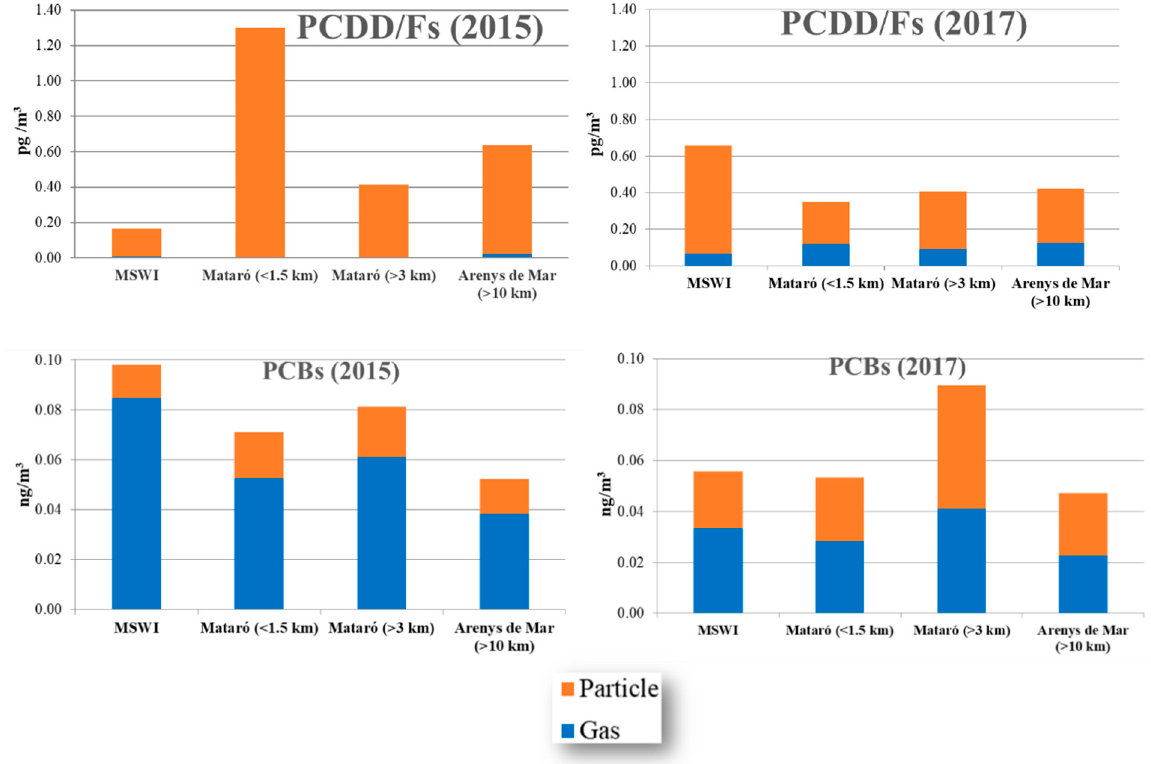
Figure 5. Gas / phase partitioning of PCDD / Fs and PCBs in air samples collected near the MSWI of Figure 5. Gas/phase partitioning of PCDD/Fs and PCBs in air samples collected near the MSWI of Matar ó in 2015 and 2017. Mataró in 2015 and 2017. Table 1. Environmental exposure to PCDD / Fs (ng WHO-TEQ / kg · day) and PCBs (ng / kg · day) by the adult population living in di ff erent locations around the MSWI of Matar ó